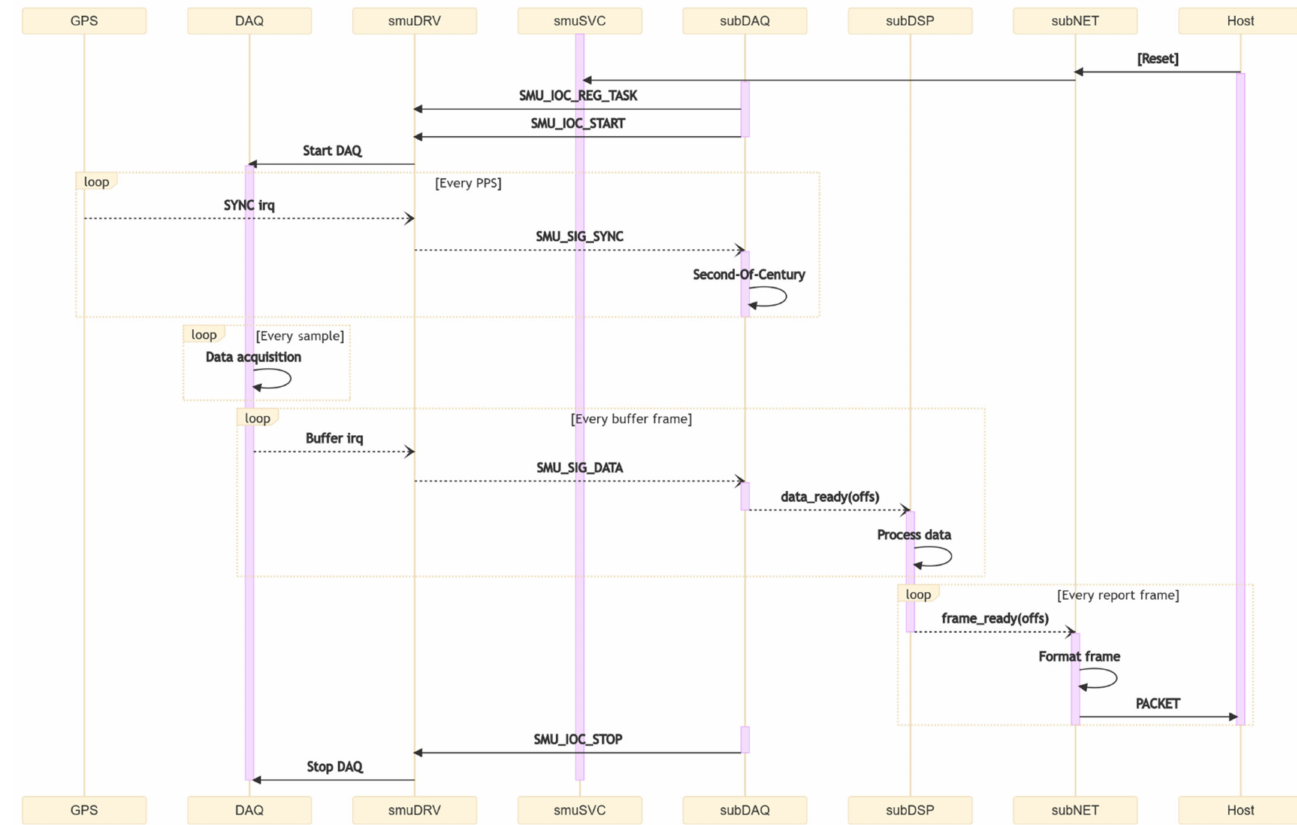
Figure 8. Sequence diagram of standard SMU operation. Arrows show the flow of information: system calls (solid) right-to-left and system signals (dashed)